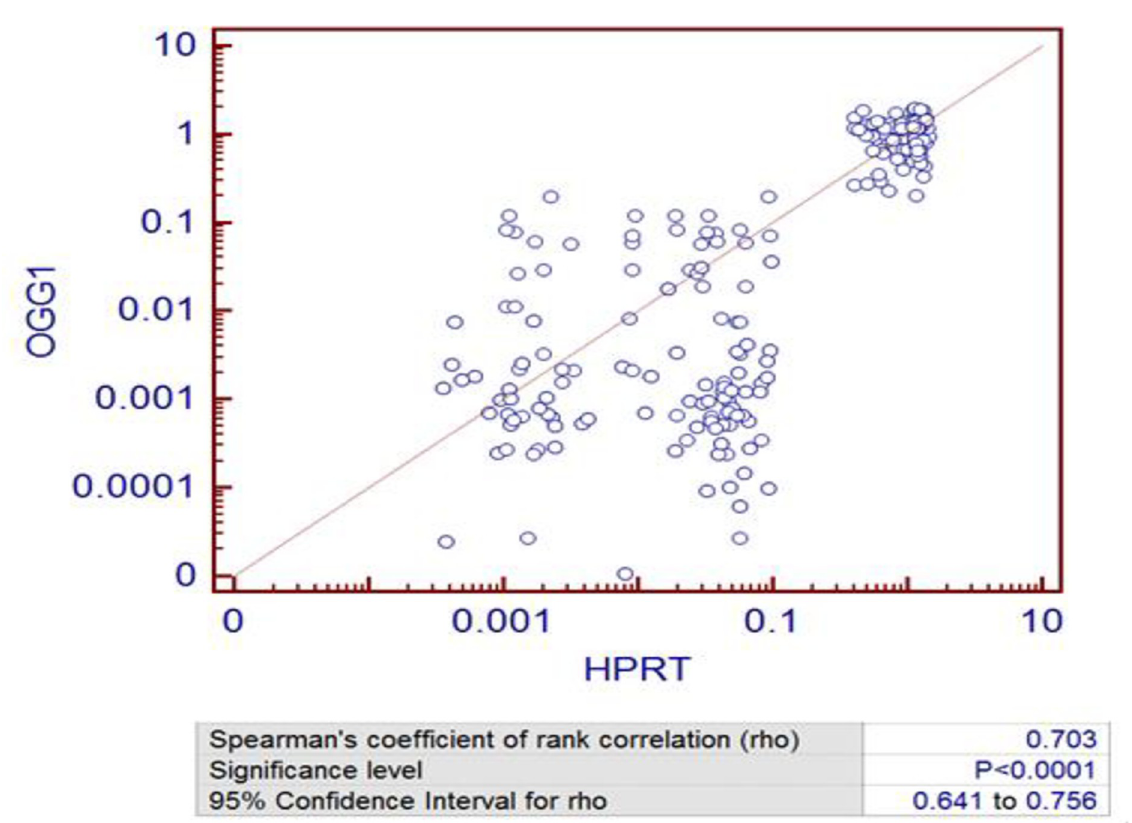
Fig 5. Co-expression analysis of OGG1 gene vs HRPT gene in industrial exposed